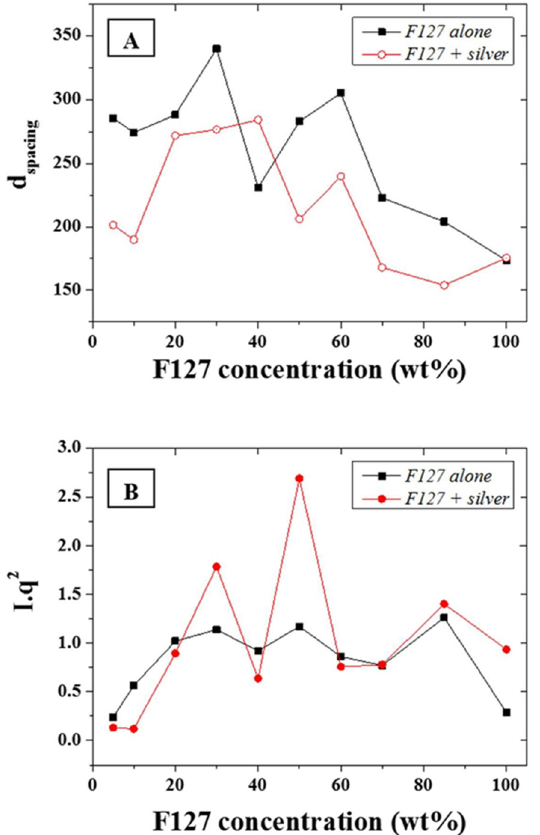
Figure 4. ( A ) d-spacing in Angstrom (Å) for the F127 series with and without addition of silver NPs; and ( B ) Calculated I * q 2 for the same